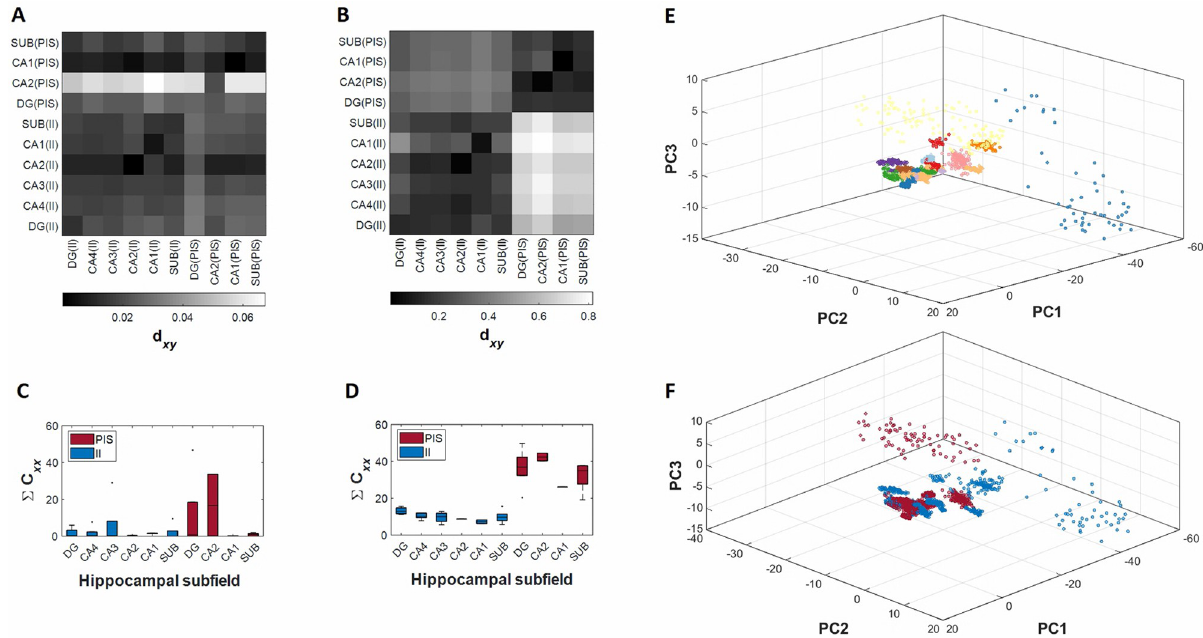
Fig 2. Correlation with a common physiological mechanism. Average distance between autocorrelation C xx and cross-correlation C xy from (A) electrophysiological records and from (B) series of interspike intervals. The color bar shows the degree of similarity, with blue indicates more correlation (less distance between C xx and C xy ). Distributions of sum of normalized autocorrelation coefficients from (C) electrophysiological records and from (D) series of interspike intervals. (E) Correlation of waveform morphologies from II and PIS activities with PCA. Each color represents a patient in which the electrophysiological signals was recorded. (F) Same picture as (E) but emphasizing the discrimination of II (blue) and PIS (red) activities.